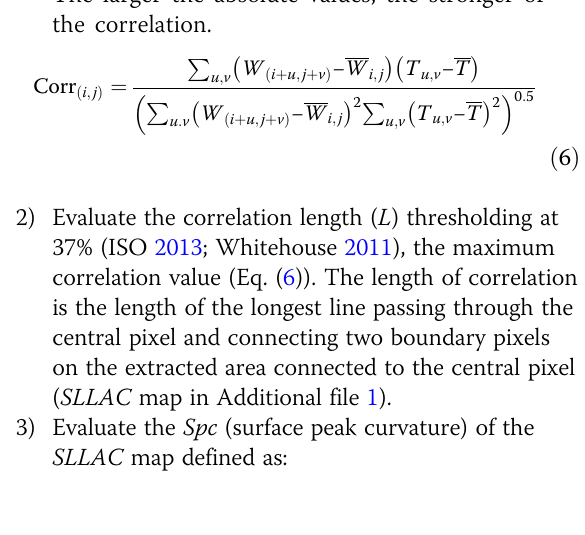
algorithm computes a normalised cross- correlation between a template and the patch, in the spatial frequency domain, and reports a standardised value that ranges between 0